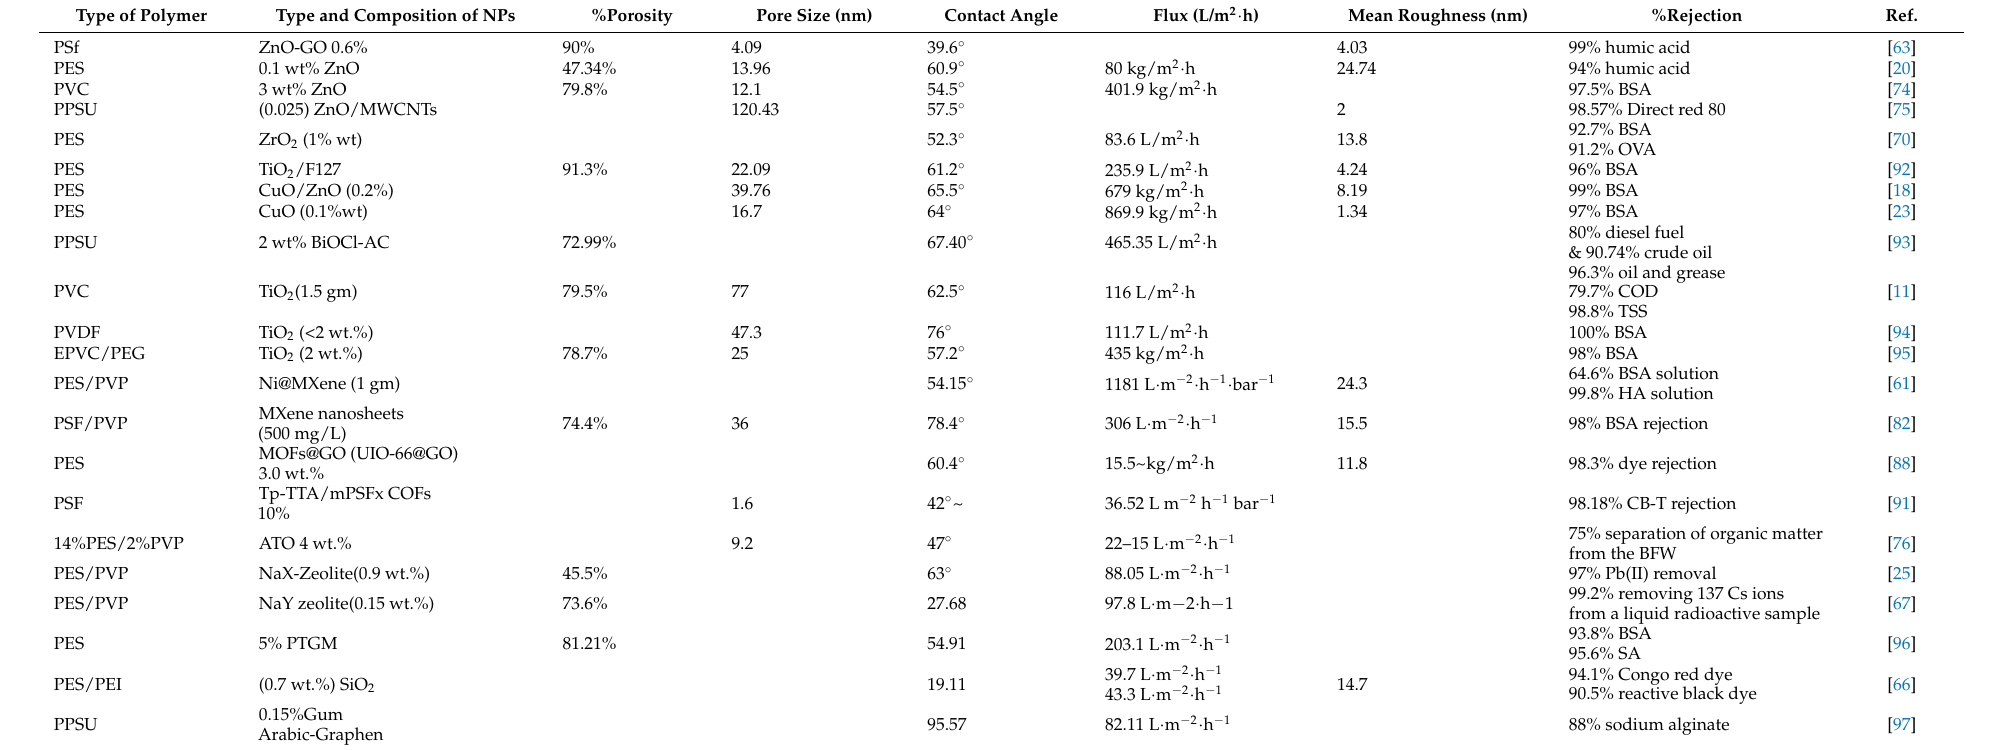
Table 2. Characteristics of UF MMMs prepared with different polymers and